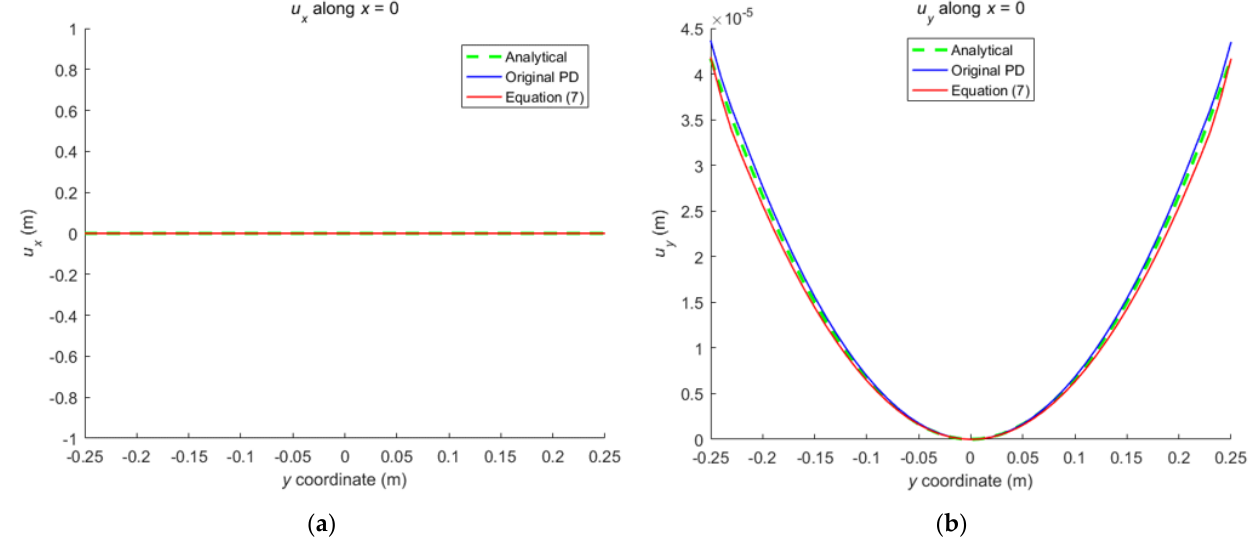
Figure 15. The displacement along the horizontal line y = 0 when the plate bending: ( a ) u x along y = 0; ( b ) u y along y = 0.